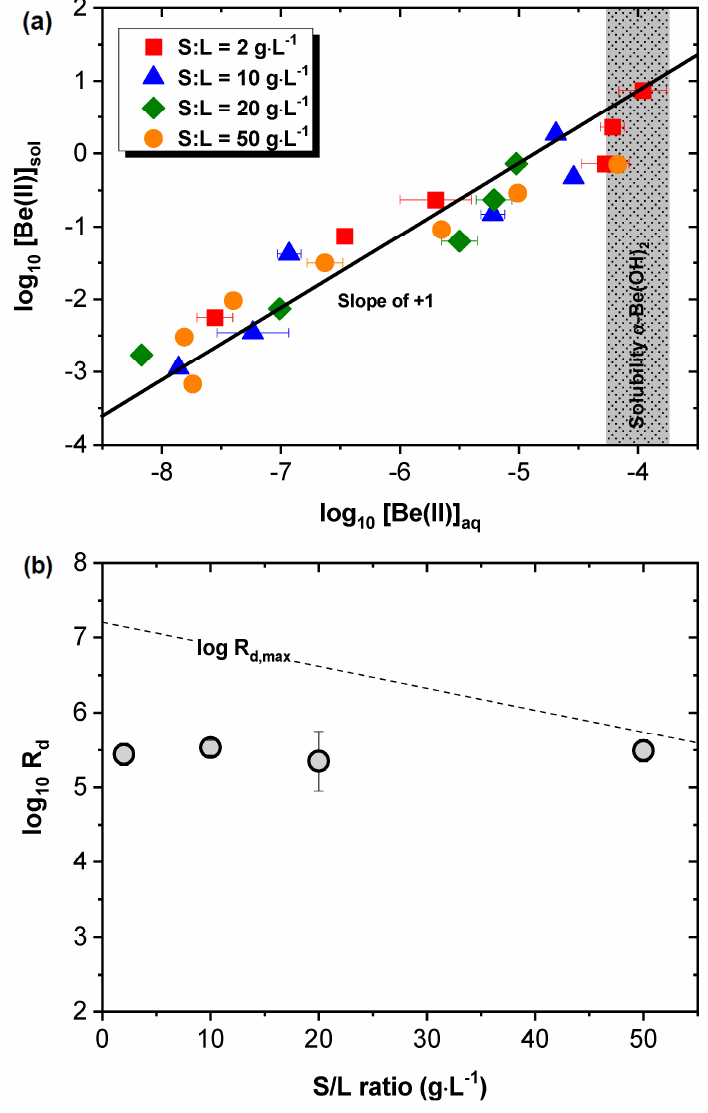
Figure 3. ( a ) Sorption isotherms of Be(II) taken up by HCP in degradation stage I with S/L = 2–50 g · L − 1 . Grey regions correspond to the solubility limit of α -Be(OH) 2 (cr) calculated for ACW using thermodynamic data reported in [13]. ( b ) Values of log R d calculated for the uptake of Be(II) by HCP in degradation stage I with S/L = 2–50 g · L − 1 . Dashed line corresponds to log R d,max , the highest log R d that can be determined at each S:L ratio on the basis of the detection limit of